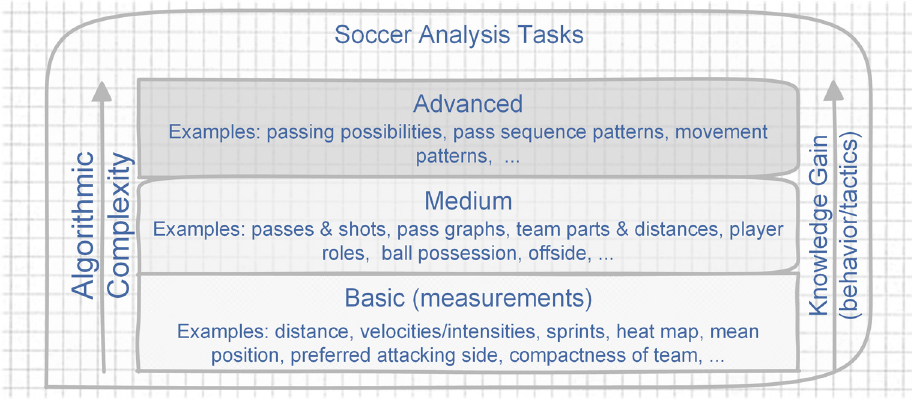
Figure 1. The typical football analysis tasks arranged in three levels of complexity.